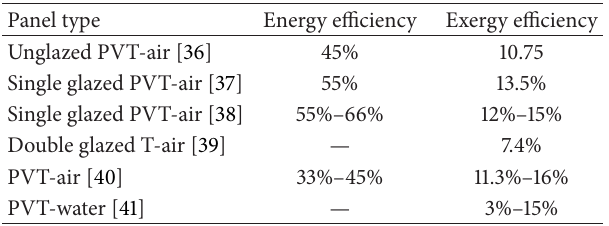
Table 1: Comparison of energy and exergy